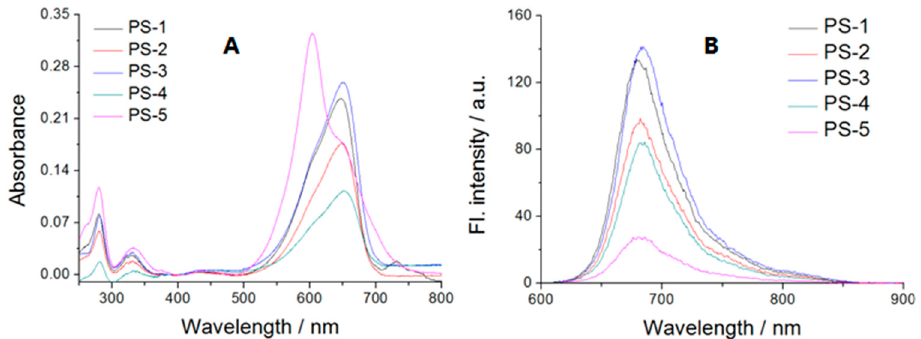
Figure 2. Absorption ( A ) and fluorescence (( B ), excitation at λ 600 nm) spectra of PS1 – PS5 at 5 μ M in water.